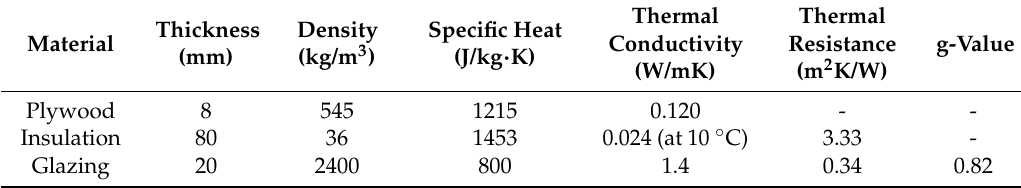
Table 2. Thermal properties of STB materials.